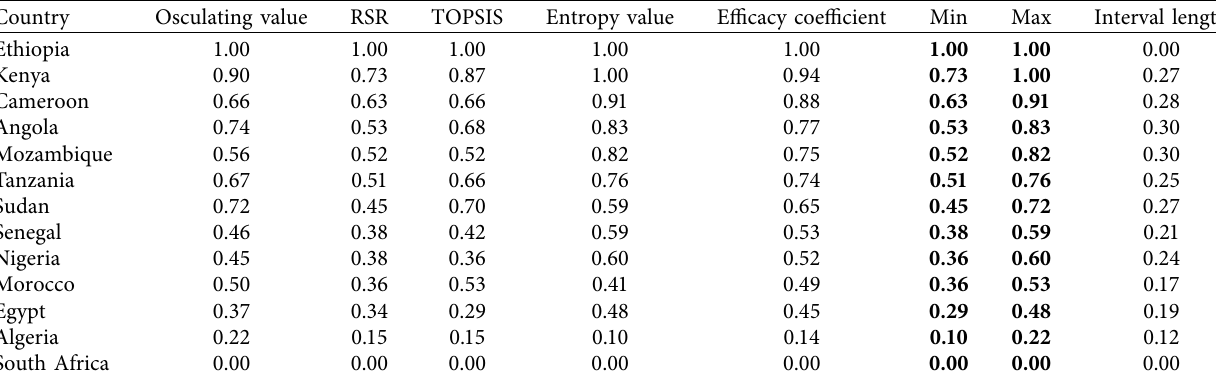
Table 7: Matching result of Chinese power companies in